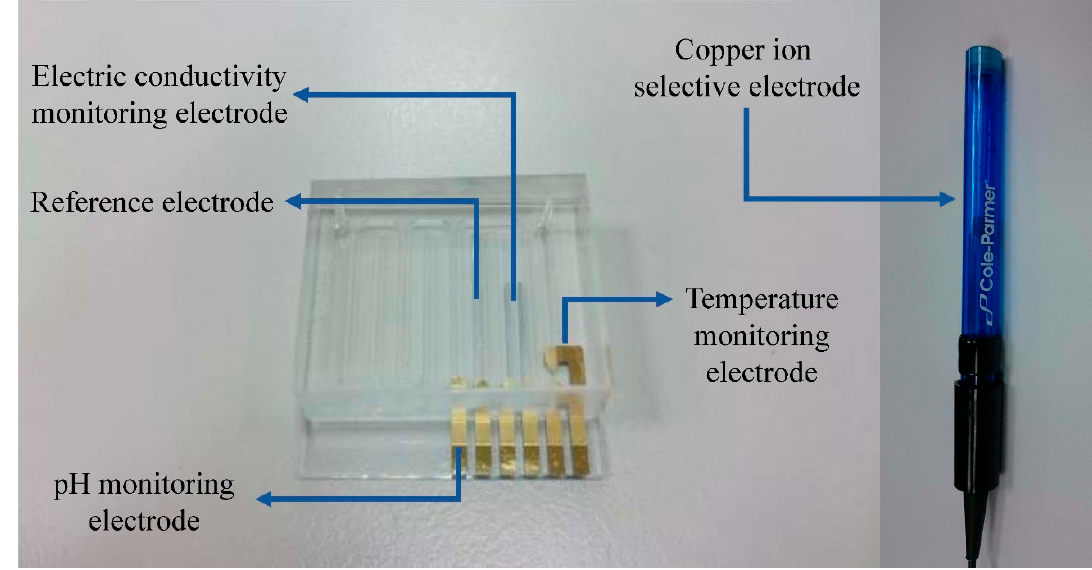
Figure 3. The sensing electrodes of the water quality monitoring module.